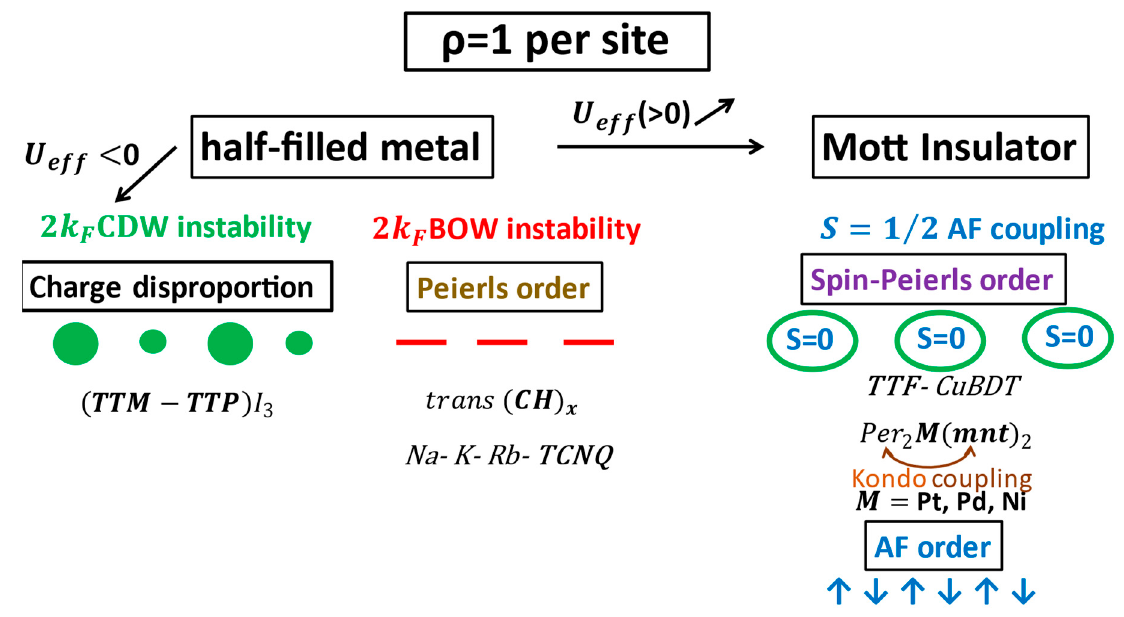
Figure 1. Electronic phase diagram of the half-filled chain. The various electronic instabilities and ground states are schematically described. Typical experimental examples are also indicated. The stack bearing the instability is in bold text.